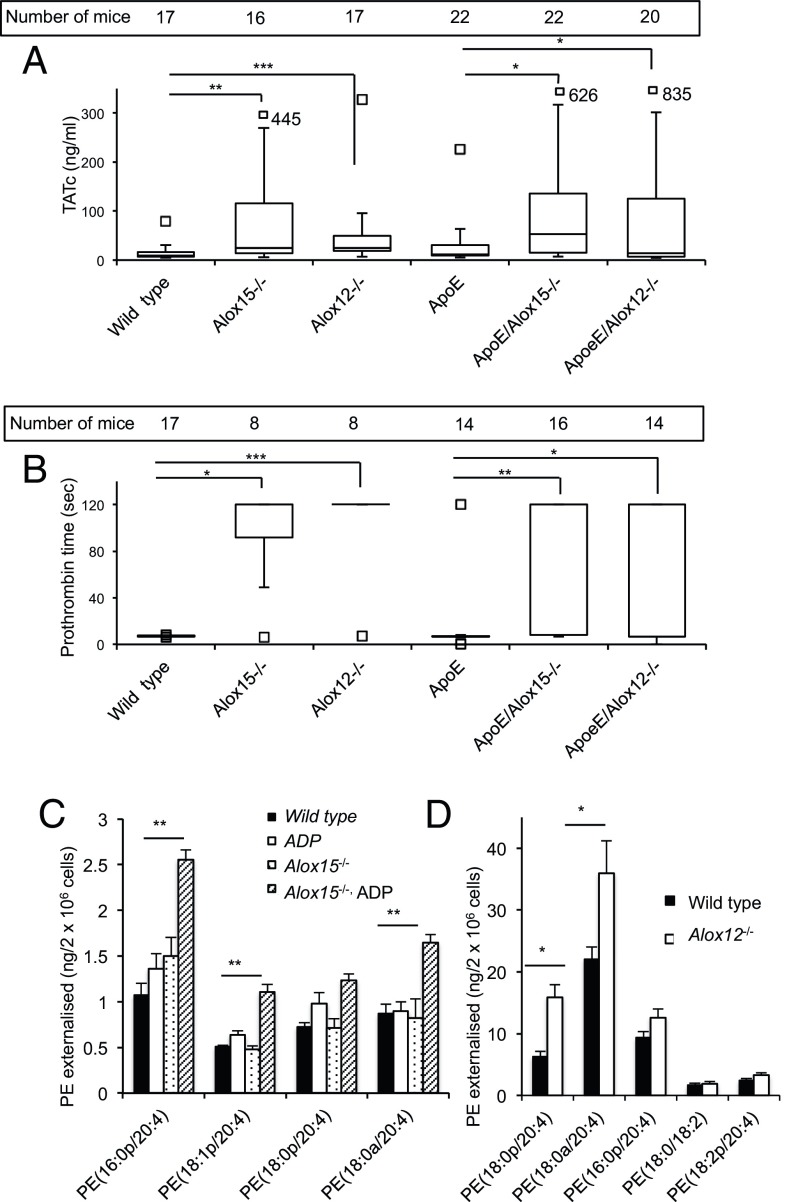
Alox12
−/− or Alox15
−/− mice show disruption of the thrombosis/bleeding axis, with increased aPL externalization in circulating blood cells. (A) Alox12 or Alox15 deficiency promotes thrombin generation in vivo in wild-type and ApoE−/− mice. Plasma from 19-wk-old mice was isolated as in Materials and Methods. Thrombin/anti-thrombin (TAT) complexes were measured using ELISA. (B) Alox12 or Alox15 deficiency reduces clotting in wild-type and ApoE−/− mice. Mouse plasma obtained as in B was tested for PT as in Materials and Methods. For A and B, data were analyzed using Mann–Whitney nonparametric u test and shown on box plots (median, with whiskers representing interquartile range), ***P < 0.001, **P < 0.01, *P < 0.05. (C) Eosinophils from Alox15−/− mice externalize more PE than wild type on ADP activation. Eosinophils generated as described in Materials and Methods were activated using 40 μM ADP before PE externalization determined (n = 3, mean ± SEM). (D) Platelets from Alox12−/− mice externalize more PE than wild type on thrombin activation. Mouse platelets were isolated as described in Materials and Methods, and PE externalization was determined. Data were analyzed using Student’s t test and expressed as mean ± SEM (n = 10). **P < 0.01, *P < 0.05 (n = 10).